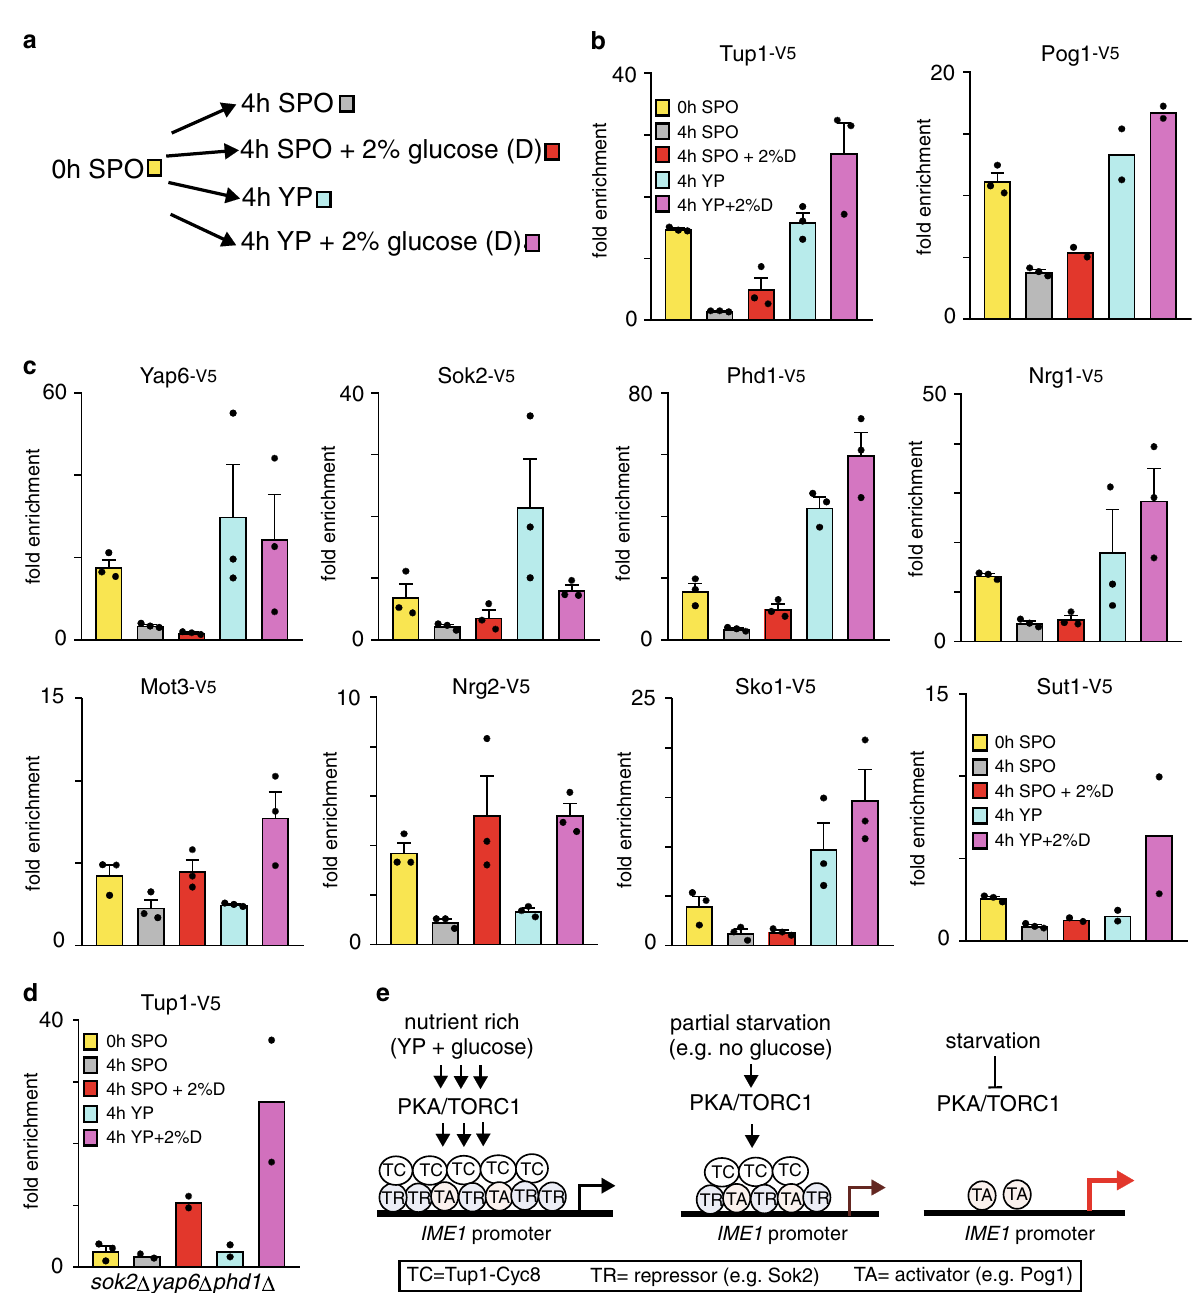
Fig. 8 Distinct nutrient cues trigger TFs to interact with the IME1 promoter. a Schematic of the experimental set up. Following growth in YPD and pre- sporulation medium, cells were shifted to SPO, SPO plus 2% glucose, YP or YP plus 2% glucose for 4 h. b Binding of Tup1 and Pog1 at the IME1 promoter under distinct nutrient conditions described in ( a ), as measured by ChIP. Diploid cells harbouring V5 tagged Tup1 (FW3456) or Pog1 (FW968) were used for the analyses. Normalised mean signals and SEM of n = 3 are displayed, except for Pog1-V5 in SPO plus 2% glucose, YP and YPD conditions for which the mean of n = 2 is shown. c Similar to b , except that V5 tagged Yap6, Sok2, Phd1, Nrg1, Mot3, Nrg2, Sko1 and Sut1 were used for the analyses (FW3833, FW5638, FW4466, FW4393, FW4383, FW4396, FW4389 and FW6974). Mean signals and SEM of n = 3 are displayed, except for Sut1-V5 for SPO plus 2% glucose, YP and YPD conditions for which the mean of n = 2 is shown. d Similar to b , except that Tup1 binding to the IME1 promoter was determined in the sok2 Δ phd1 Δ yap6 Δ cells (FW4010). Mean signals for n = 2 are displayed, except for 0 h in SPO for which the mean and SEM of n = 3 are shown. e Model for how nutrient signalling controls the IME1 promoter. Multiple Tup1 – Cyc8 recruiting TFs associate in nutrient rich conditions with the IME1 promoter. During partial starvation some TFs dissociate from the IME1 promoter, but Tup1 – Cyc8 remains bound. Upon entry into meiosis all TFs and Tup1 – Cyc8 dissociate, and consequently IME1 transcription is